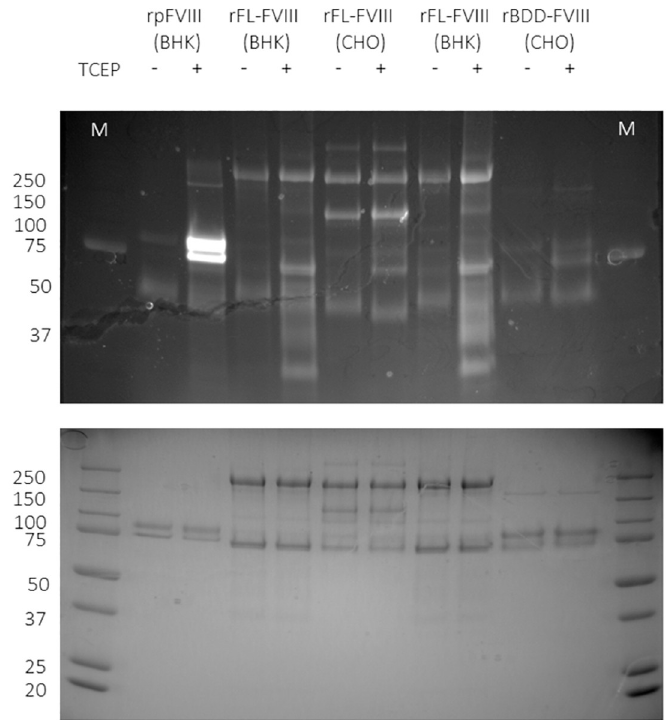
Fig 8. TCEP-mediated reduction of a selection of FVIII products. A selection of FVIII products were incubated with PBS or reduced with 1 mM TCEP and free -SH groups visualised with the Alexa Fluor 488-maleimide fluorescent label. FVIII products tested include recombinant porcine FVIII (rpFVIII) produced in Baby Hamster Kidney (BHK) cells, two recombinant full-length FVIII (rFL FVIII) products also produced in BHK cells, a rFL-FVIII product produced in Chinese Hamster Ovary (CHO) cells, and a recombinant B domain deleted FVIII product produced in BHK cells.